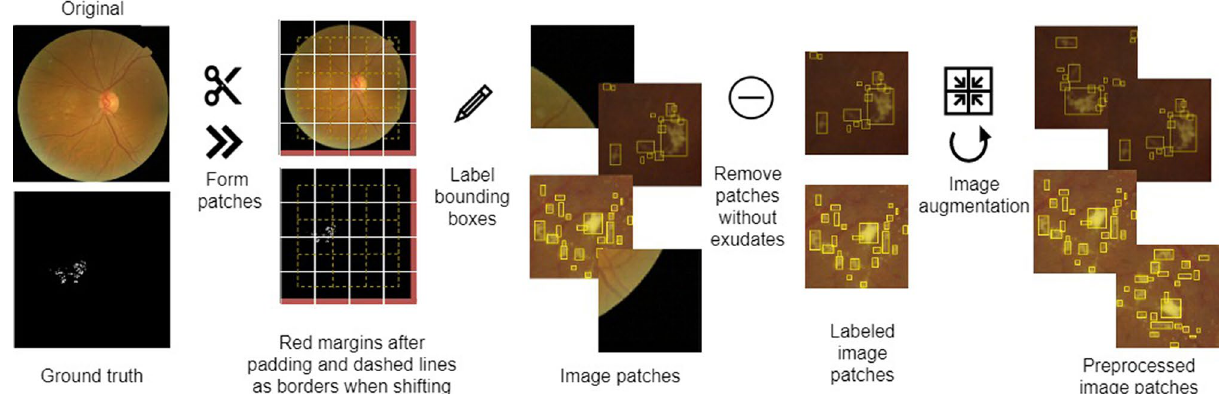
Figure 2. Creation of training data patches from retinal images and their ground-truth binary masks.